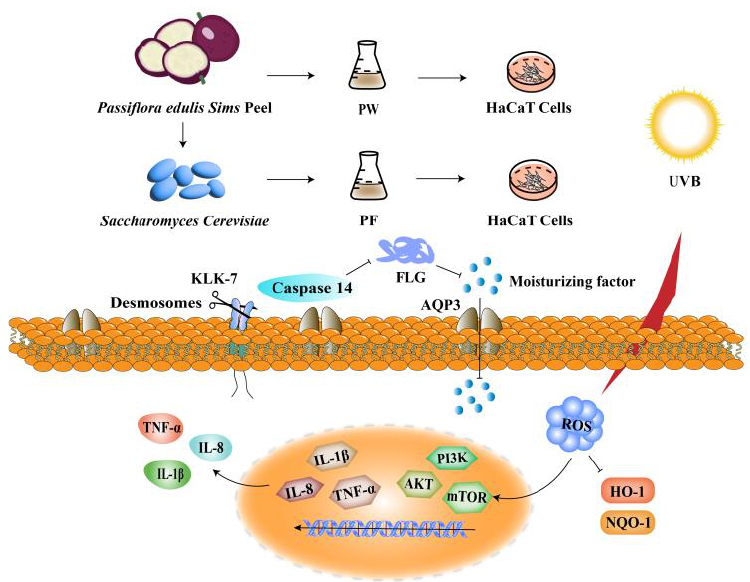
Figure 1. Protective effects of PF and PW on HaCaT damaged by